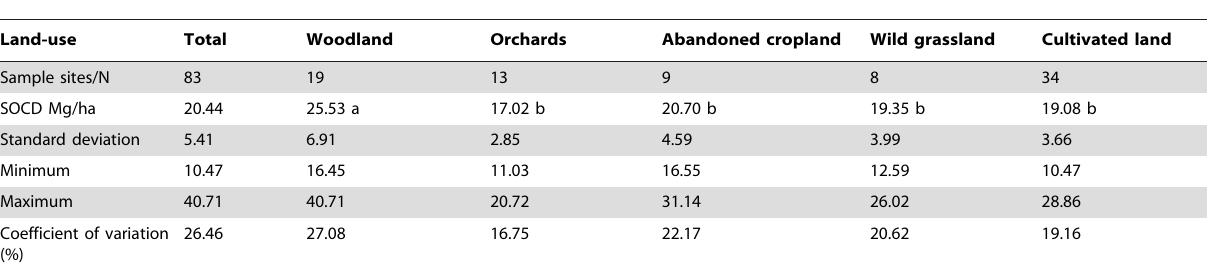
Table 2. Topsoil (0–20 cm) SOCD of different